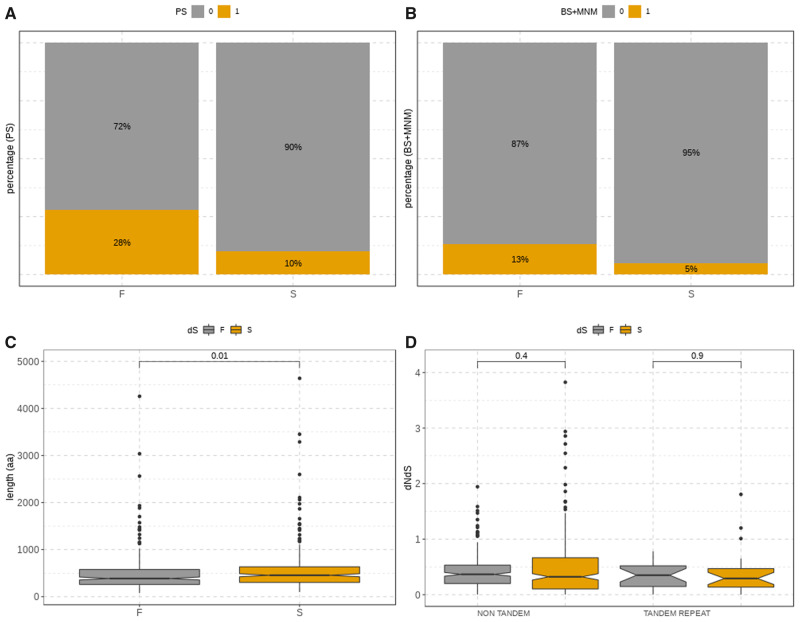

Acyrthosiphon pisum genes from the selected duplications classified as Fast (F) or Slow (S) according to dS, after filtering duplications with dS > 2 and dS < 0.01 (201 strict duplicates remained, see Materials and Methods for details). (A) Percentage of genes under positive selection (PS = 1 in ochre) or with no signal of positive selection (PS = 0 in gray); (B) percentage of genes positively selected after BS + MNM model (BS + MNM = 1 in ochre) or not (BS + MNM = 0 in gray); (C) cDNA length (in aa); and (D) dN/dS after classifying duplicates according to their relative location (i.e., tandem and nontandem duplicates). P values were estimated using wilcox.test function from R.